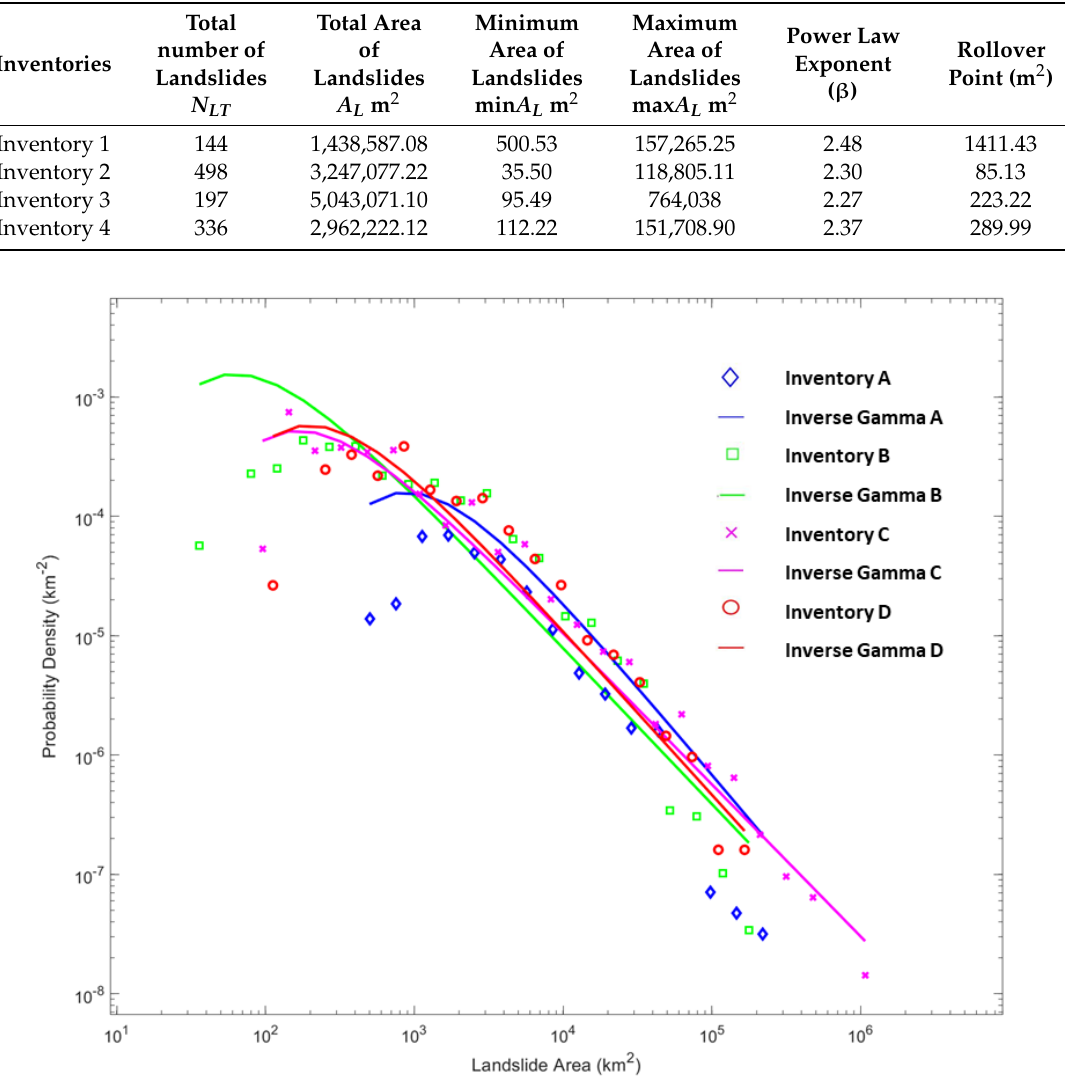
Table 4. Comparison of the frequency area statistics of the landslide area.